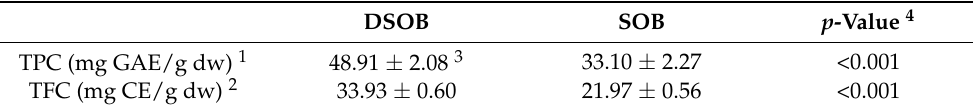
Table 3. Total phenolic content (TPC) and total flavonoid content (TFC) of defatted seeds of Oenothera biennis (DSOB) and seeds of Oenothera biennis (SOB).